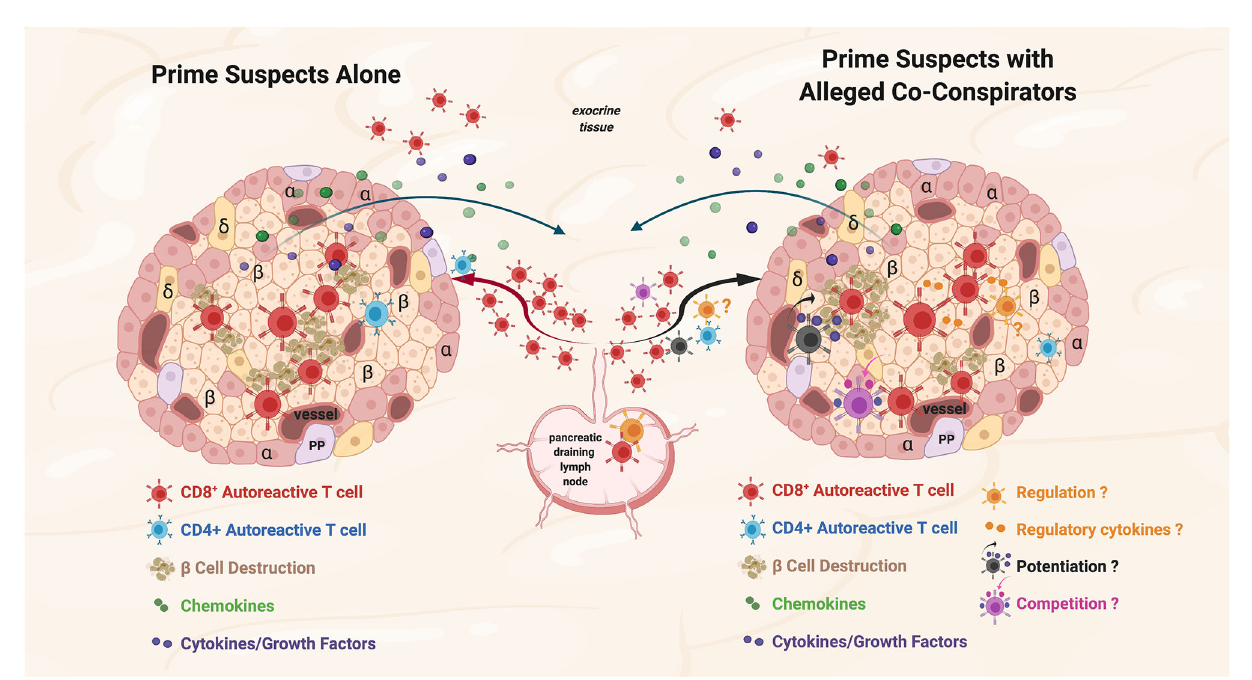
FIGURE 1 | Prime suspects and alleged co-conspirators at the scene of the crime: function of islet-reactive T cells and potential function(s) of non-islet-reactive T cells in insulitis. Proposed schema for islet and non-islet cell reactive T cell functions in insulitis. Representative alpha ( a ), beta, ( b ) and delta ( d ); cells, and blood vessels are labeled and shown in the represented islet on the left and on the right. The islets are depicted as sources of chemoattractants/cytokines gradients (depicted in green and purple symbols, respectively) through venules with the resultant egress of lymphocytes from the pancreatic draining lymph nodes (pLN) and migration to the islets. Autoreactive CD4 + T cells are depicted in blue. On the left, the prime suspects, b − cell cytolytic function of islet-reactive CD8 + T cells (depicted in brick red) with b cell destruction depicted in brown. For both representative islets, auto-reactive CD8 + T cells are shown in the exocrine tissue. On the right, three potential functions of the alleged co-conspirators, non-islet-reactive T cells, on b − cell destruction by the prime suspects, are depicted. A pro- in fl ammation ‘ potentiating ’ T cell (depicted in black) with cytokine/growth factor secretion (depicted in green and purple) and increased b − cell destruction are depicted in brown. The potential suppressive function of a Treg on b − cell destruction and the potential regulatory effects of cytokines are depicted in orange. The competitive function(s) of a resource/nutrient/growth factor consuming T cells are depicted. The three proposed functions of non-islet-reactive T cells in insulitis are not necessarily mutually